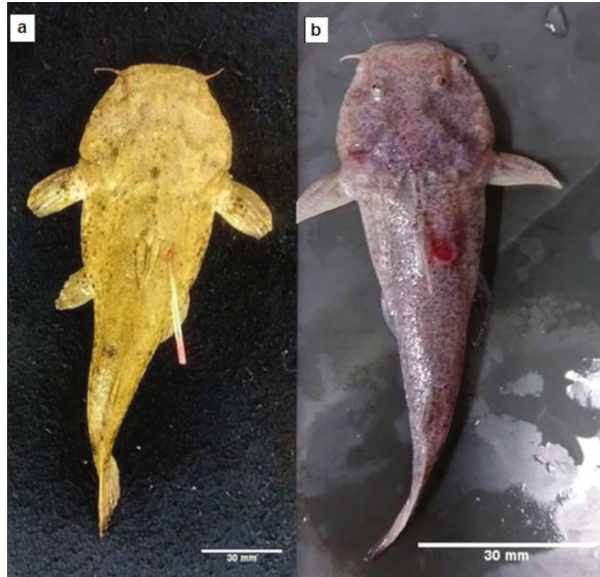
Fig. 3. Photograph of tagged Lophiosilurus alexandri . a. Large-size class animal after 90 days post-tagging. b. Small- -size class animal with wound caused after tag detachment during the experiment. Scale bar = 30